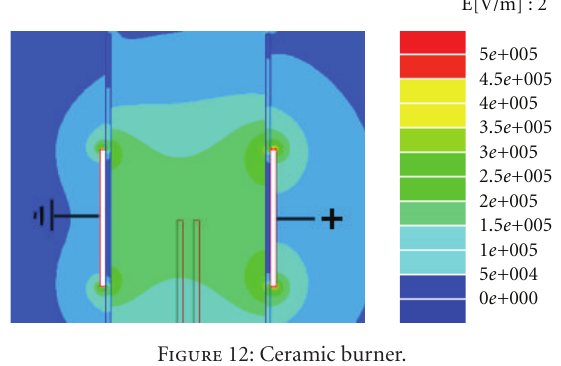
Figure 12: Ceramic burner.